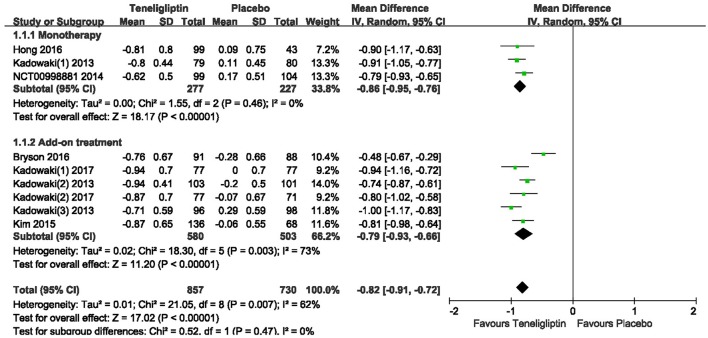
HbA1c change of teneligliptin vs. placebo from the baseline by meta-analysis.